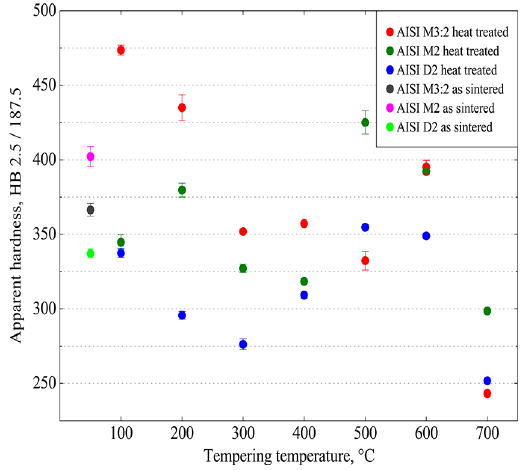
Figure 3. Variation of the Brinell apparent hardness (HB 2.5 / 187.5) for the three powder mixtures of VSI as sintered, quenched (1,150 ºC quenched in air) and double tempered at seven different